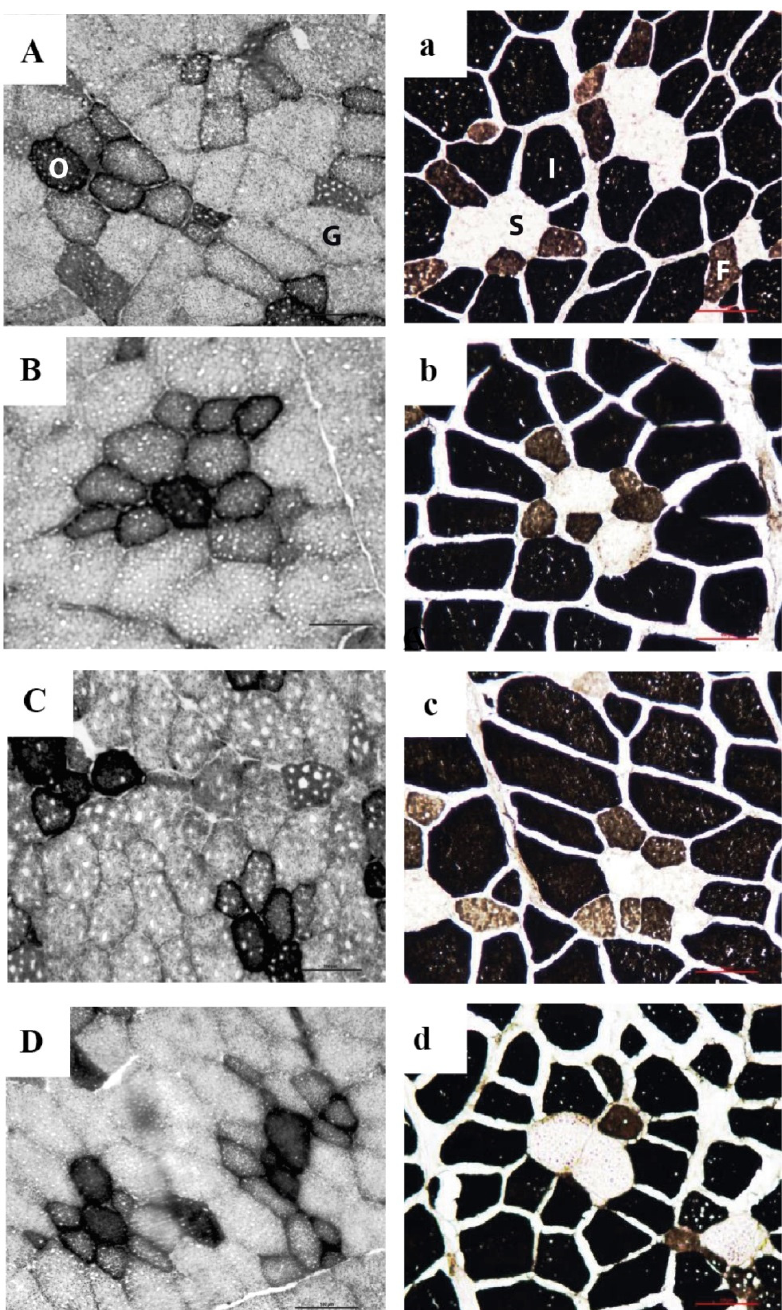
Figure 1. Transversal sections of Longissimus thoracis muscle per treatment. ( A / a ) negative control treatment (C − ), without additive; ( B / b ) positive control treatment, 10 ppm/kg of feed ractopamine hydrochloride + 0.97% g lysine; ( C / c ) (FA) treatment, 25 ppm/kg of feed FA supplementation; and ( D / d ) (FA-Lys) treatment, 25 ppm/kg of feed FA supplementation + 0.97% lysine. NADH-TR technique ( A – D ), dark fibers were identified as oxidative (O) and light fibers as glycolytic (G);